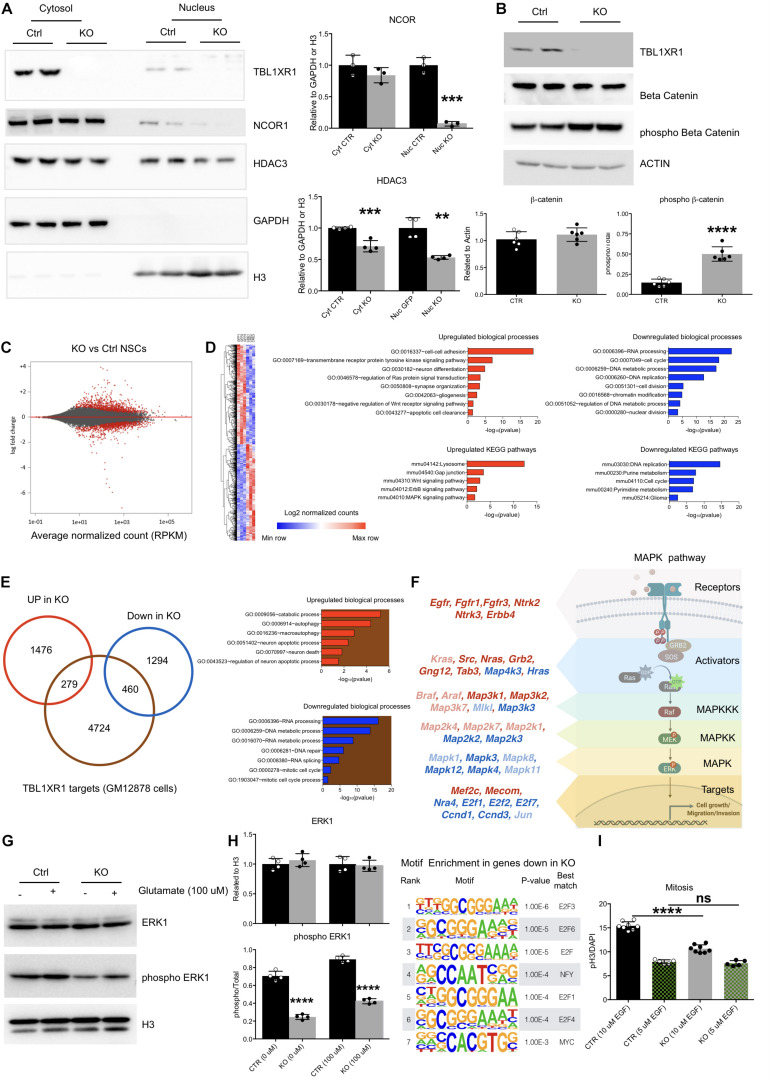
Molecular defects of Tbl1xr1 KO neural stem cells. (A) Western blot analysis of both cytosolic (enriched in GAPDH, used as normalizer) and nuclear (enriched in H3, used as normalizer) protein fractions from control and Tbl1xr1 KO in vitro NSCs for the following proteins: TBL1XR1, NCOR1, and HDAC3. On the right, the quantification of the blots for NCOR1 and HDAC3 (shown as mean + s.e.m. with dots representing individual samples): cytoplasmic NCOR1: n (biological replicates): Ctrl = 3, KO = 3: p = 0.2407; nuclear NCOR1: n (biological replicates): Ctrl = 3, KO = 3: ***p = 0.0002; cytoplasmic HDAC3: n (biological replicates): Ctrl = 4, KO = 4: ***p = 0.0007; nuclear HDAC3: n (biological replicates): Ctrl = 4, KO = 4: **p = 0.0013. Statistically compared using t-test. (B) Western blot analysis of whole protein lysates from control and Tbl1xr1 KO in vitro NSCs for the following proteins: TBL1XR1, βCATENIN and its phosphorylated form (Ser33/37/Thr41). On the right, the quantification of the blots for βCATENIN and pβCATENIN: n (biological replicates): Ctrl = 6, KO = 6: βCATENIN p = 0.2878; pβCATENIN ****p < 0.0001. Statistically compared using unpaired t-test. (C) MA plot showing log2 fold changes as function of average normalized gene expression (RPKM) for control against KO in vitro NSCs (RNAseq data). Differentially expressed genes are highlighted in red. (D) Left, heat-map showing the differentially expressed genes between control and KO NSCs. Right, Gene Ontology analysis for terms indicating both the biological processes (up) and KEGG pathways (bottom), for upregulated (red, left) and downregulated (blue, right) genes in Tbl1xr1 KO NSCs compared to control. (E) Left, Venn diagram showing the overlap between TBL1XR1 gene targets (brown, publicly available ChIP-seq data obtained from GM12878 cells) and genes up (red) and down-regulated (blue) in Tbl1xr1 KO NSCs. Right, Gene Ontology analysis for terms indicating the biological processes for TBL1XR1 targets that are also upregulated (the red/brown intersection) and downregulated (the blue/brown intersection) genes in Tbl1xr1 KO NSCs compared to control. (F) MAPK pathways found altered between control and Tbl1xr1 KO NSCs ordinated accordingly their role within the pathway (scheme on the right). Red = upregulated in mutant; blue = downregulated in mutant; dark color = statistically significant; light color = trend. (G) Western blot analysis of whole protein lysates from control and Tbl1xr1 KO NSCs treated or not with 100 μM of glutamate for the following proteins: ERK1 and its phosphorylated form (Thr202/Tyr204). On the right, the quantification: n: Ctrl = 4, KO = 4, 0 mM of glutamate: ERK1 p = 0.3898; pERK1 ****p < 0.0001; 100 μM of glutamate: ERK1 p = 0.7170; pERK1 ****p < 0.0001; Statistically compared using unpaired t-test. (H) Motif enrichment analysis using Homer on promoters (–1,000 + 100 from TSS) og genese downregulated in Tbl1xr1 KO NSCs (n = 1,754). (I) Quantification of the immunocytochemistry for PH3 in both Ctrl and Tbl1xr1 KO proliferating NSCs in a medium with either normal (10 μM) or low levels (5 μM) of EGF, counterstained with DAPI. 10 μM: n: Ctrl = 8, KO = 8, ****p < 0.0001; n: Ctrl = 5, KO = 5, p = 0.9055; one-way ANOVA. See also Supplementary Tables S2, S5.